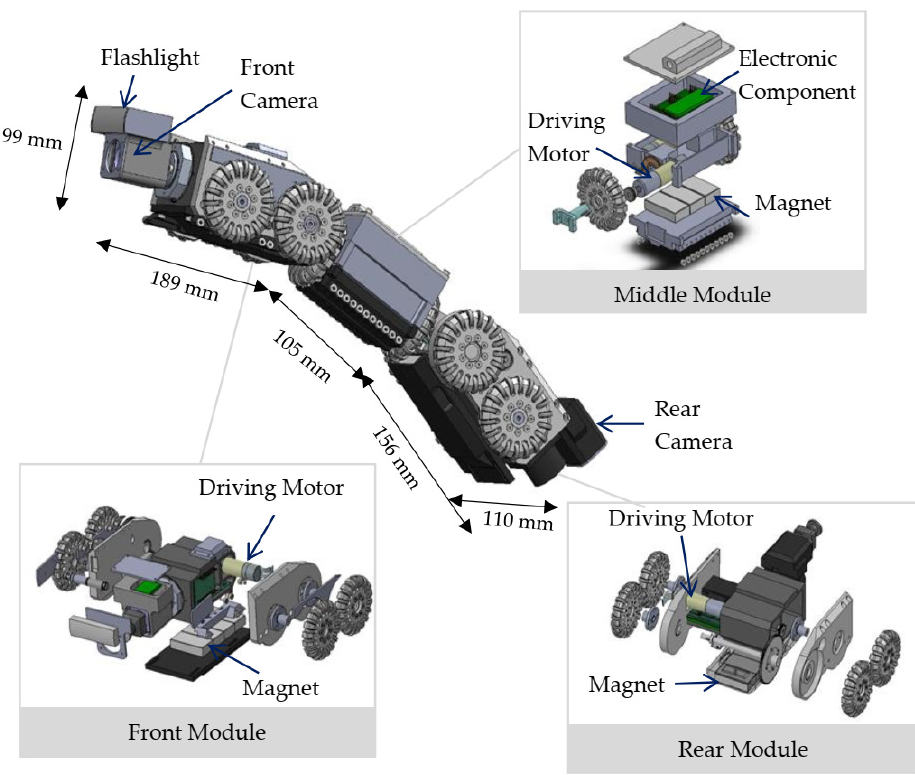
Figure 1. The 3D CAD model of the proposed in-pipe inspection robot.